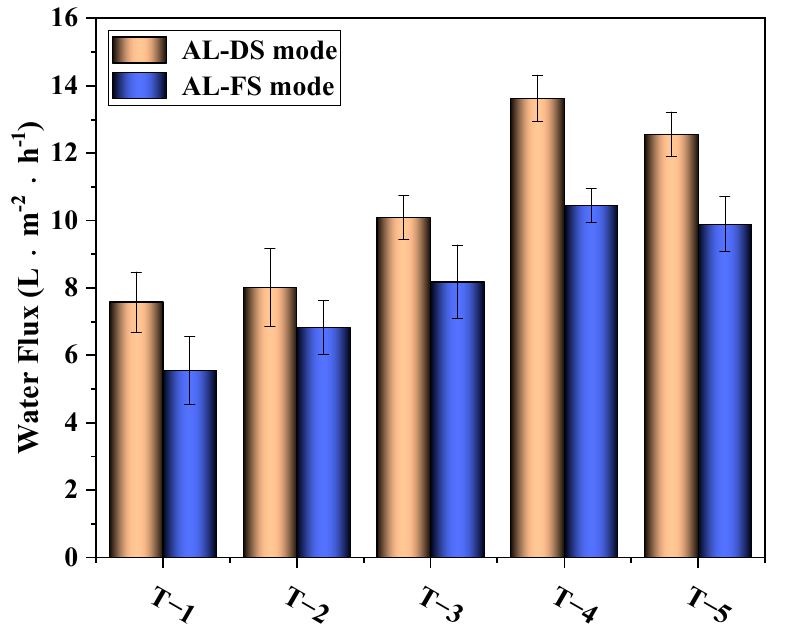
Figure 11. The effects of different amounts of MXene nano-sheets on the water flux of the TFC-FO membranes .